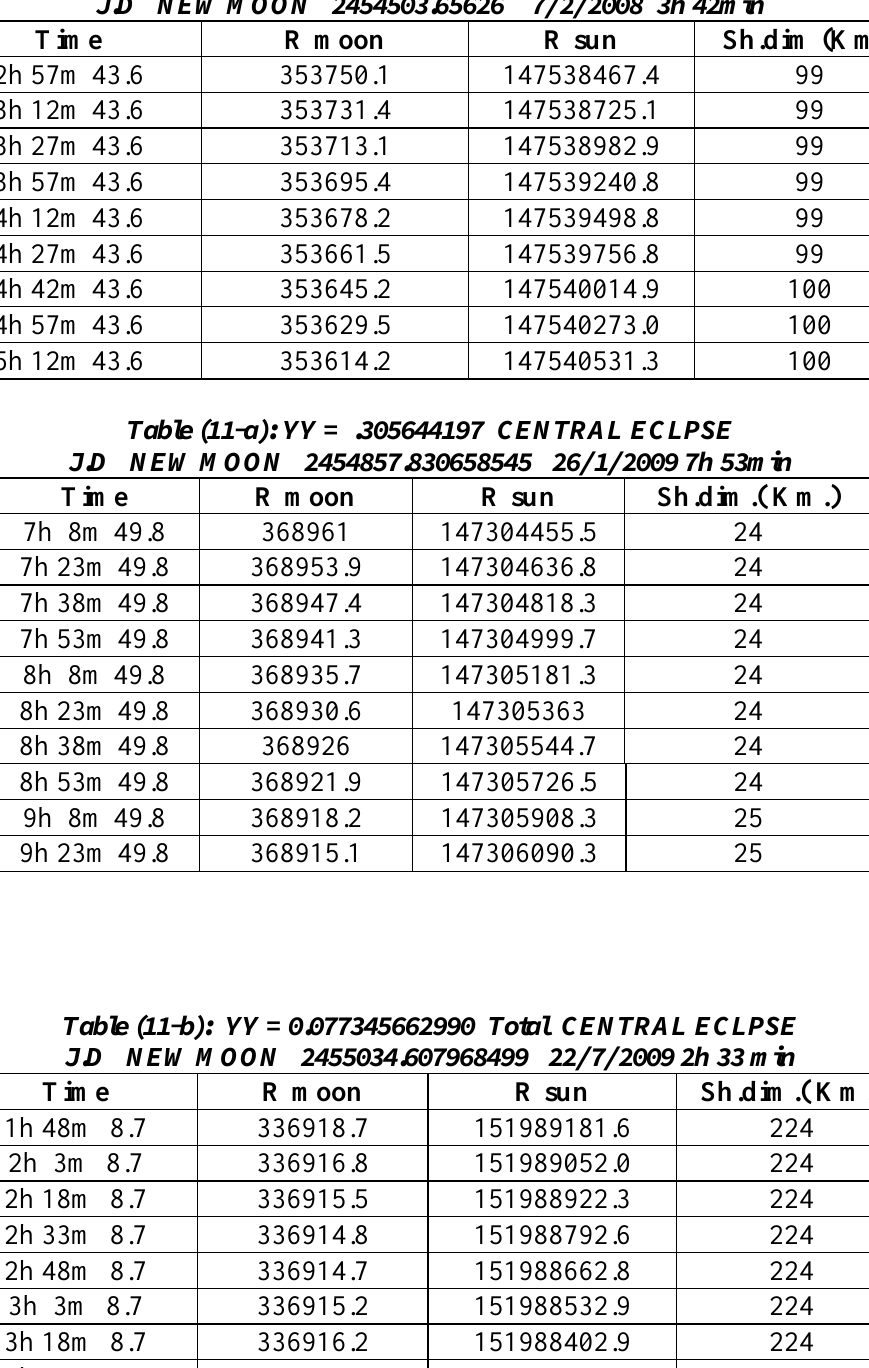
Table 10: YY = .971495462 total CENTRAL ECLPSE